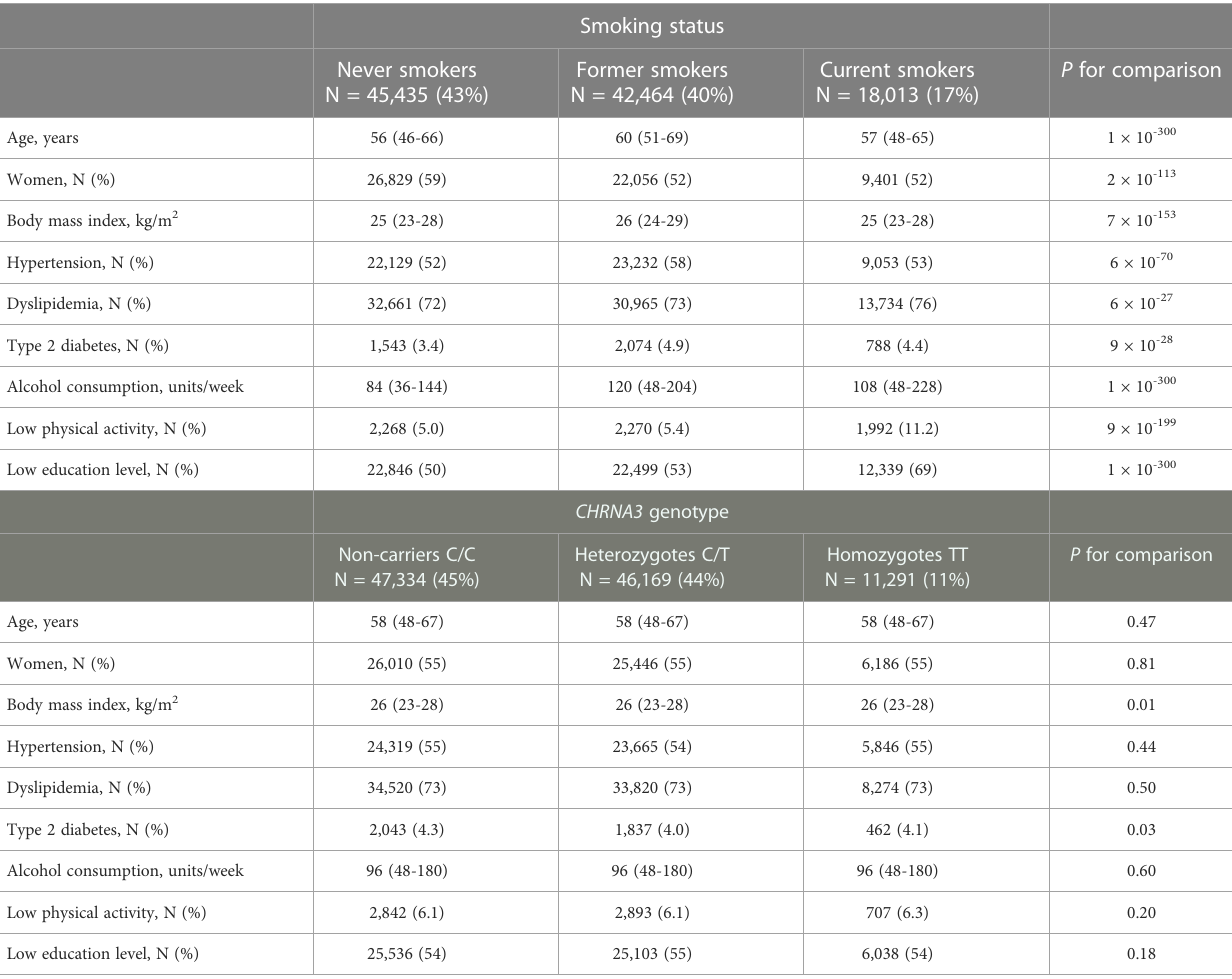
TABLE 1 Baseline characteristics at the day of enrollment according to smoking status (upper section) and genotype (lower section) in individuals from the Copenhagen General Population